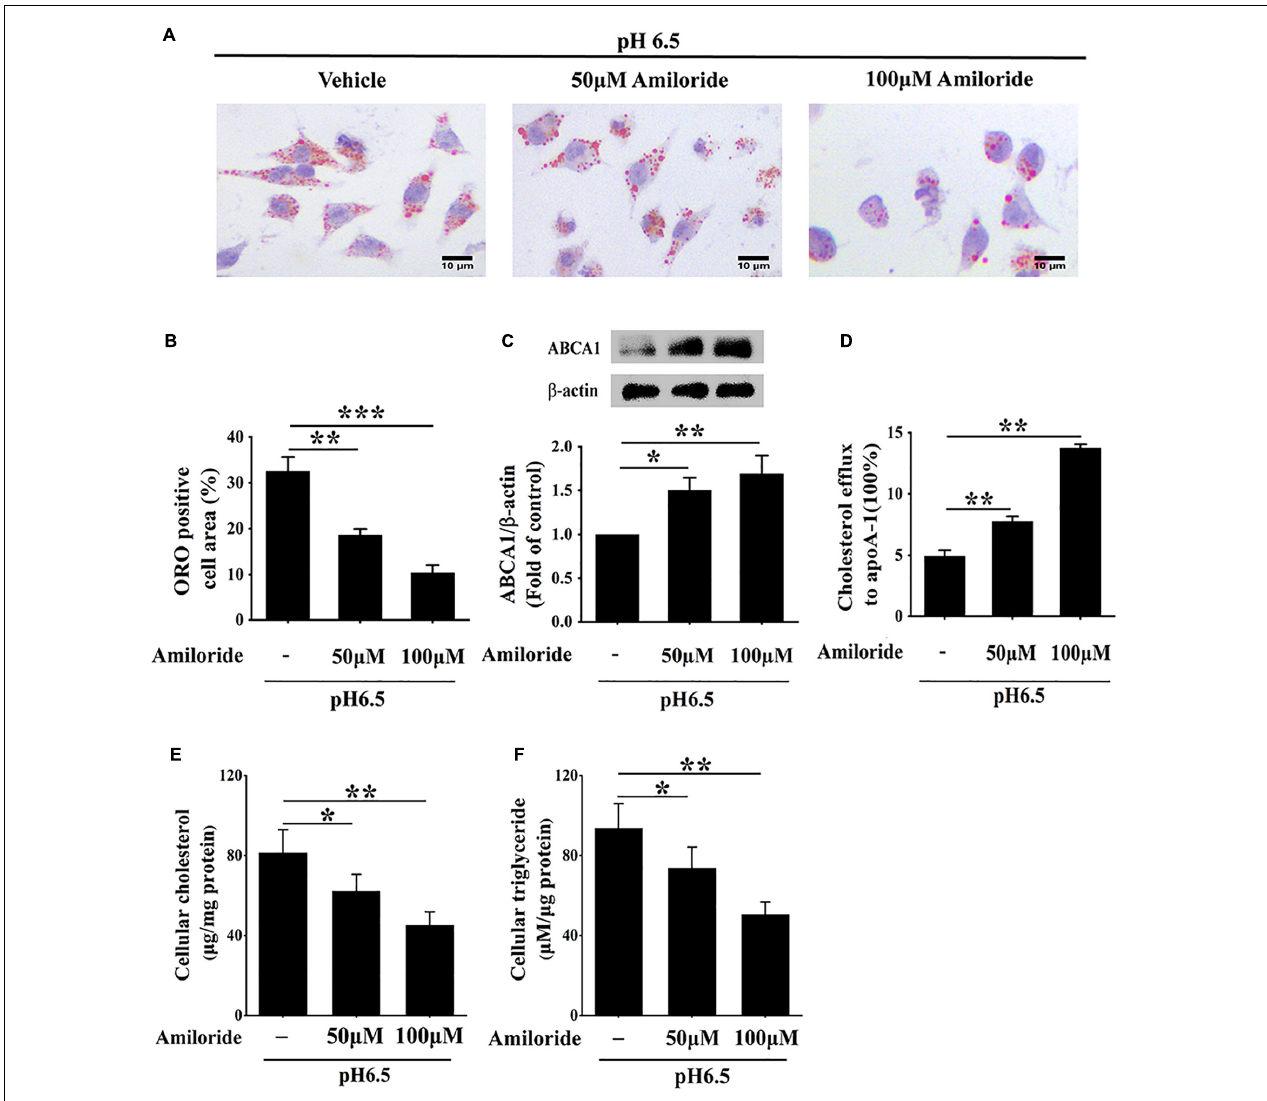
FIGURE 5 | Inhibition of ASIC1 impedes lipid accumulation and promotes ABCA1-mediated cholesterol efflux of macrophages. RAW 264.7 macrophages were cultured in 25 µ g/ml ox-LDL and amiloride (0, 50, and 100 µ M) under pH 6.5 condition for 24 h. (A) Lipid deposition was detected by ORO staining. (B) ORO positive areas were quantified. (C) ABCA1 protein levels were measured using WB analysis. (D) ABCA1-mediated cholesterol efflux was determined using an NBD-cholesterol kit. (E,F) Intracellular cholesterol and triglycerides contents were determined by enzymatic assay. Data were shown as the mean ± SEM from 3 to 4 independent experiments. Statistical analysis was performed by one-way ANOVA. * P < 0.05; ** P < 0.01; *** P <